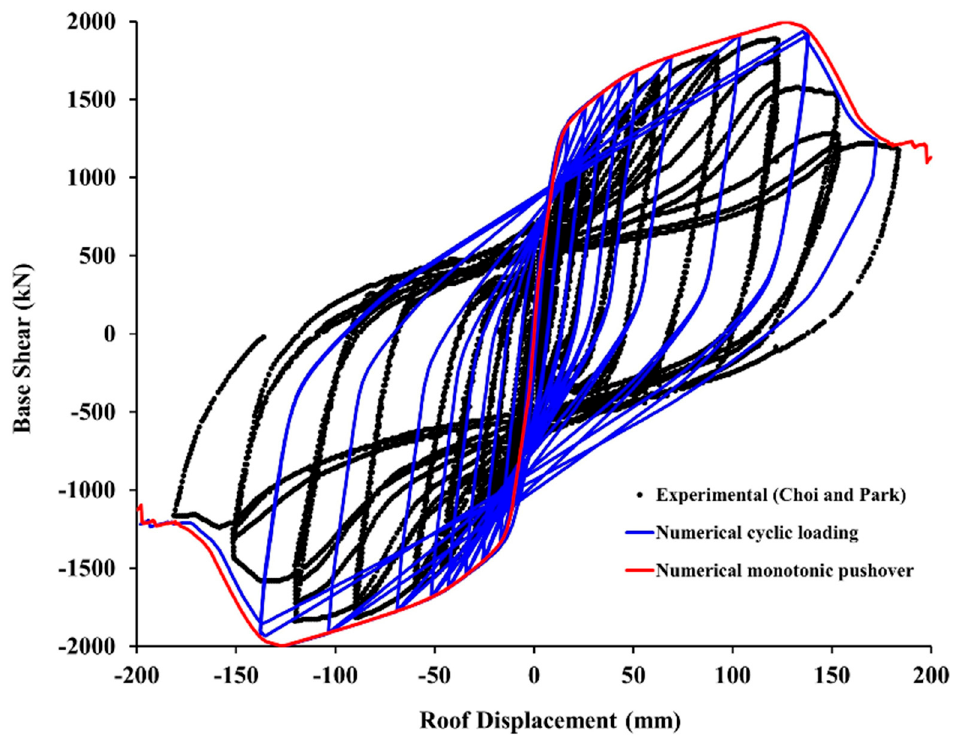
Figure 11. Comparison between numerical and experimental pushover curves for the three-story specimen by Choi and Park [56].